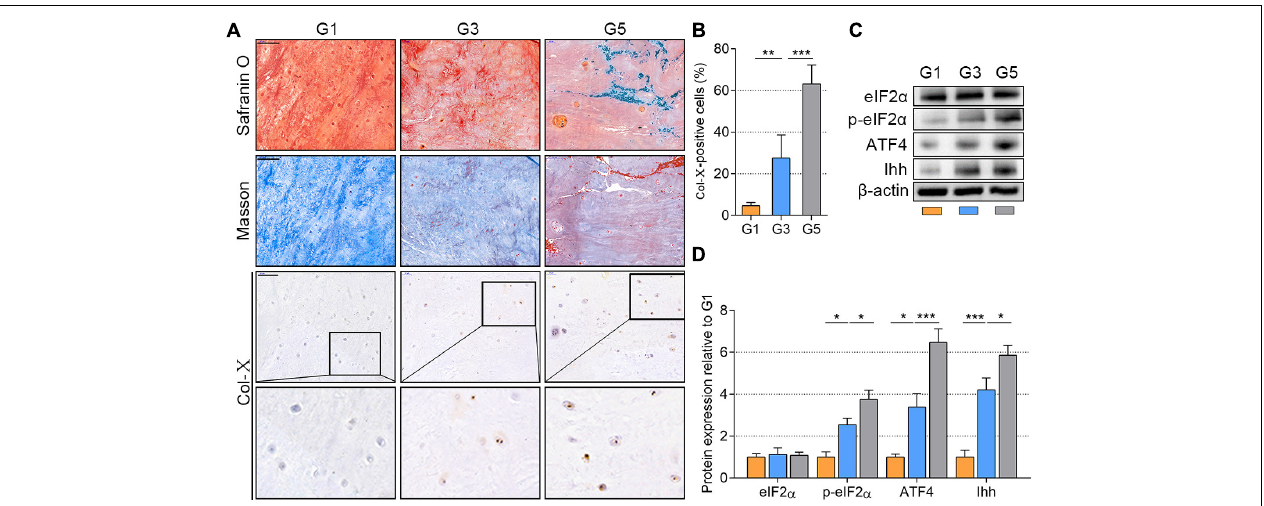
FIGURE 1 | p-eIF2 α , ATF4, and Ihh expression in human NP tissues with different degeneration degrees (G1, G3, and G5 according to Pfirrmann grade). (A) Representative images of Safranin O staining with collagen and NP cells appearing orange and fibers blue/violet; Masson’s staining with collagen and NP cells appearing blue and fibers red; IHC staining for Col-X (scale bar = 100 µ m) and (B) quantification of Col-X-positive cells (%). (C) eIF2 α , p-eIF2 α , ATF4, and Ihh protein levels were assessed by WB, (D) measured by densitometric analyses, and expressed as folds relative to G1 samples. Data are presented as means ± SD ( n = 6). * p < 0.05, ** p < 0.01; *** p < 0.001; the orange column indicates G1, the blue column indicates G3, and the gray column indicates G5. p-eIF2 α , phosphorylated eukaryotic initiation factor-2 α ; ATF4, activating transcription factor 4; Ihh, Indian hedgehog; NP, nucleus pulposus; IHC, Immunohistochemistry; Col-X, collagen X; eIF2 α , eukaryotic initiation factor-2 α ; WB, western